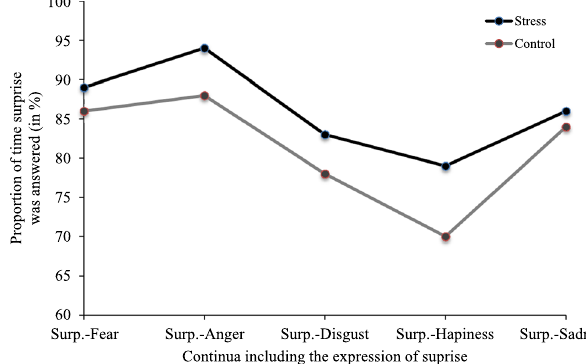
Figure 7. Proportion of time surprise was answered when it was the dominant expression presented; for each combination of emotions including surprise and between experimental